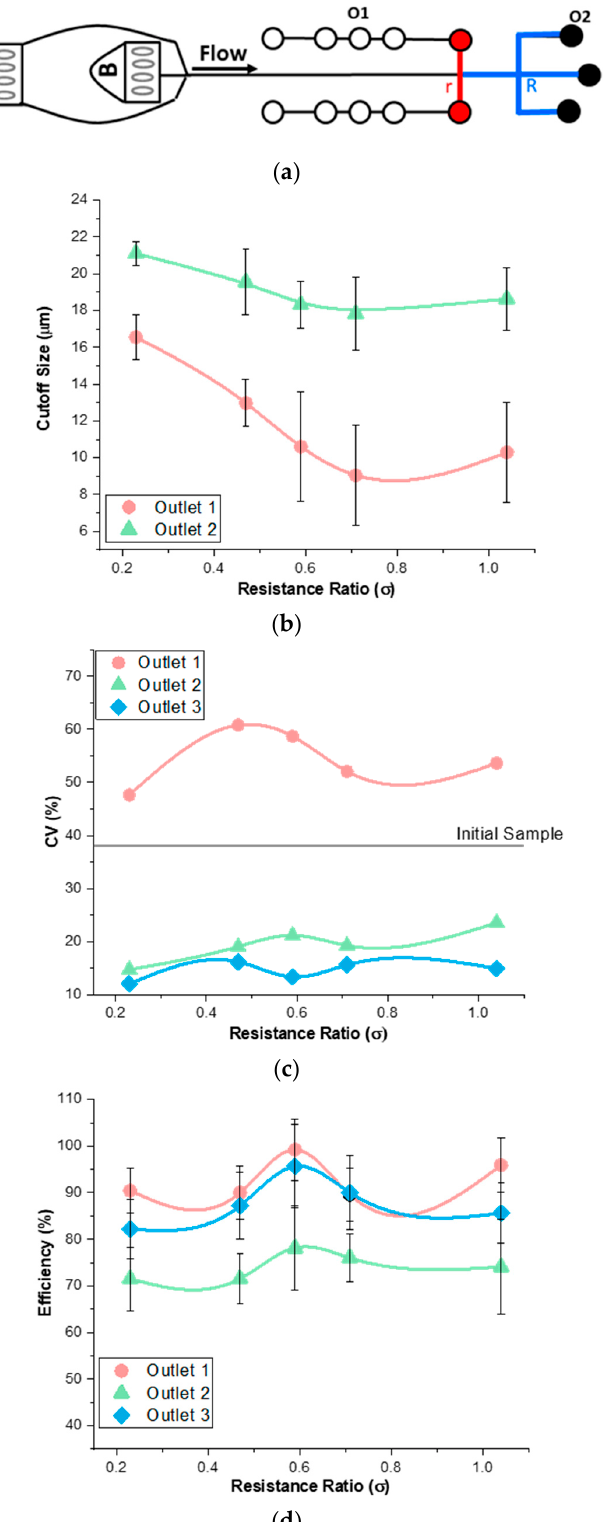
Figure 5. Influence of resistance ratio on device performance. ( a ) Schematic of resistance modification in outlet 1. ( b ) Cutoff size rapidly decreases in outlets 1 and 2 when resistance decreases. ( c ) Coefficient of variance (CV) decreases in outlet 1 and increases in outlets 2 and 3 as resistance ratio increases. ( d ) Efficiency of separation is highest when resistance is at σ = 0.59.